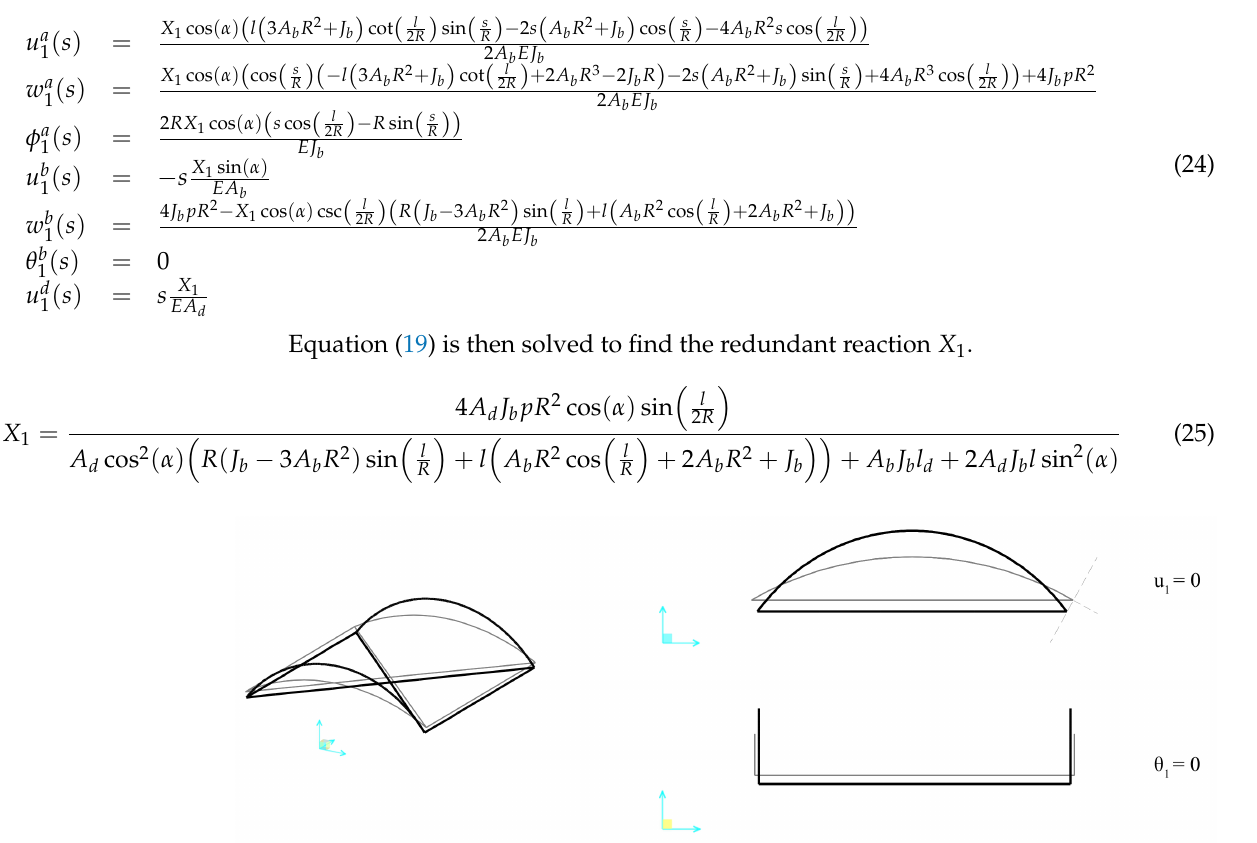
Figure 7. Deformed configuration of the problem